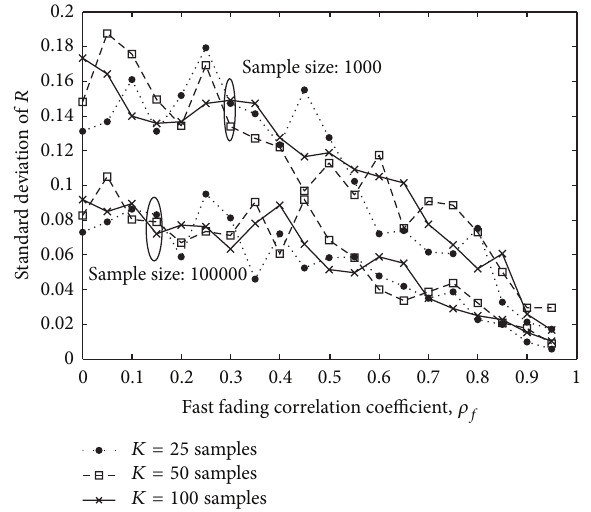
Figure 2: Standard deviation of the sample correlation coefficient as a function of the fast fading correlation coefficient for a number of observations 𝑁 = 1000, 100000 and number of samples 𝐾 = 25, 50, 100 . The distribution parameters are 𝑚 = 𝜎 = 8 𝜎 𝑑1 𝑑2